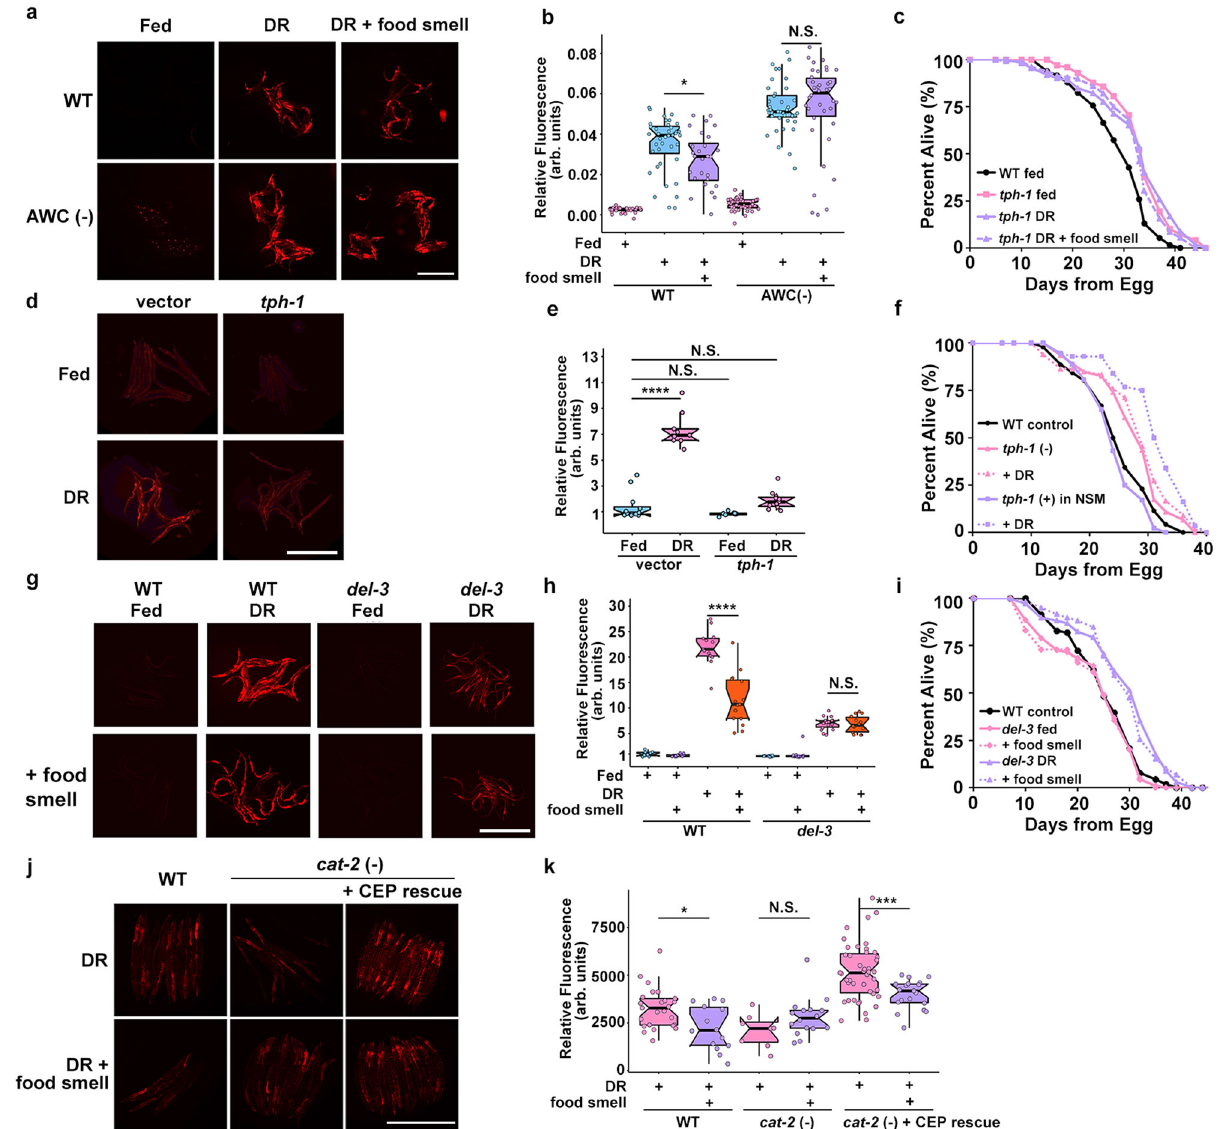
Fig. 3 Food signals requires the AWC, NSM, and CEP neurons. Images ( a ) and quanti fi cation ( b ) of fmo-2p :: mCherry in a WT (control) and AWC genetic ablation background on fed (pink), DR (blue), or DR exposed to food smell (purple). Scale bar, 1 mm. n = 36 (WT fed), 40 (WT DR), 28 (WT DR + food smell), 41 (AWC(-) fed), 40 (AWC(-) DR), 38 (AWC(-) DR + food smell) biologically independent animals. p-value = 0.0203 (WT DR vs. WT DR + food smell), 0.926 (AWC(-) DR vs AWC(-) DR + food smell). Survival curves ( c ) of WT animals (black) and tph-1 KO animals on fed (pink) and DR (purple) conditions exposed to food smell (dotted lines). Images ( d ) and quanti fi cation ( e ) of fmo-2p :: mCherry exposed to tph-1 RNAi on fed (blue) or DR (pink). Scale bar, 1 mm. n = 12 (vector fed), 9 (vector DR), 10 ( tph-1 fed), 11 ( tph-1 DR) biologically independent animals. p -value = 5.87e-10 (vector fed vs. vector DR), 0.108 (vector fed vs. tph-1 fed), 0.221 (vector fed vs. tph-1 DR). Survival curves ( f ) comparing control (black), tph-1 KO (pink), and tph-1 NSM-speci fi c rescue (purple) animals on fed (solid line) and DR (dotted lines). Control (black) survival curve is also displayed in Supplementary Fig. 5F. Data in f and Supplementary Fig. 5f were acquired concurrently. Images ( g ) and quanti fi cation ( h ) of fmo-2p :: mCherry in a WT (control) and del-3 KO background on fed (blue) and DR (pink) exposed to food smell (purple and orange, respectively). Scale bar, 1 mm. n = 11 (WT fed), 13 (WT fed + food smell), 13 (WT DR), 15 (WT DR + food smell), 10 ( del-3 fed), 12 ( del-3 fed + food smell), 14 ( del-3 DR), 11 ( del-3 DR + food smell) biologically independent animals. p - value = 1.32e-06 (WT DR vs. WT DR + food smell), 0.212 ( del-3 DR vs. del-3 DR + food smell). Survival curves of conditions comparing WT (black) to del- 3 ( i ) on fed (pink) and DR (purple) conditions in combination with food smell (dotted lines). WT control (black) survival curve is also displayed in Supplementary Fig. 6a. Data in i and Supplementary Fig. 6a were acquired concurrently. Images ( j ) and quanti fi cation ( k ) of fmo-2 p::mCherry in a WT, cat-2 KO, or cat-2 KO with cat-2 CEP neuron rescue on DR (pink) and DR + food smell (purple). Scale bar, 1 mm. n = 25 (WT DR), 14 (WT DR + food smell), 8 ( cat-2 (-) DR), 16 ( cat-2 (-) DR + food smell), 43 ( cat-2 (-) + CEP rescue DR), 19 ( cat-2 (-) + CEP rescue DR + food smell) biologically independent animals. p -value = 0.0103 (WT DR vs. WT DR + food smell), 0.0922 ( cat-2 (-) DR vs. cat-2 (-) DR + food smell), 0.000114 ( cat-2 (-) + CEP rescue DR vs. cat-2 (-) + CEP rescue DR + food smell). * P < .05, *** P < .001 and **** P < .0001 (Welch Two Sample t -test, two-sided). The box plots display the median by the middle line of the box. The upper boundary of the box indicates the 75% interquartile range, and the lower boundary indicates the 25% interquartile range.